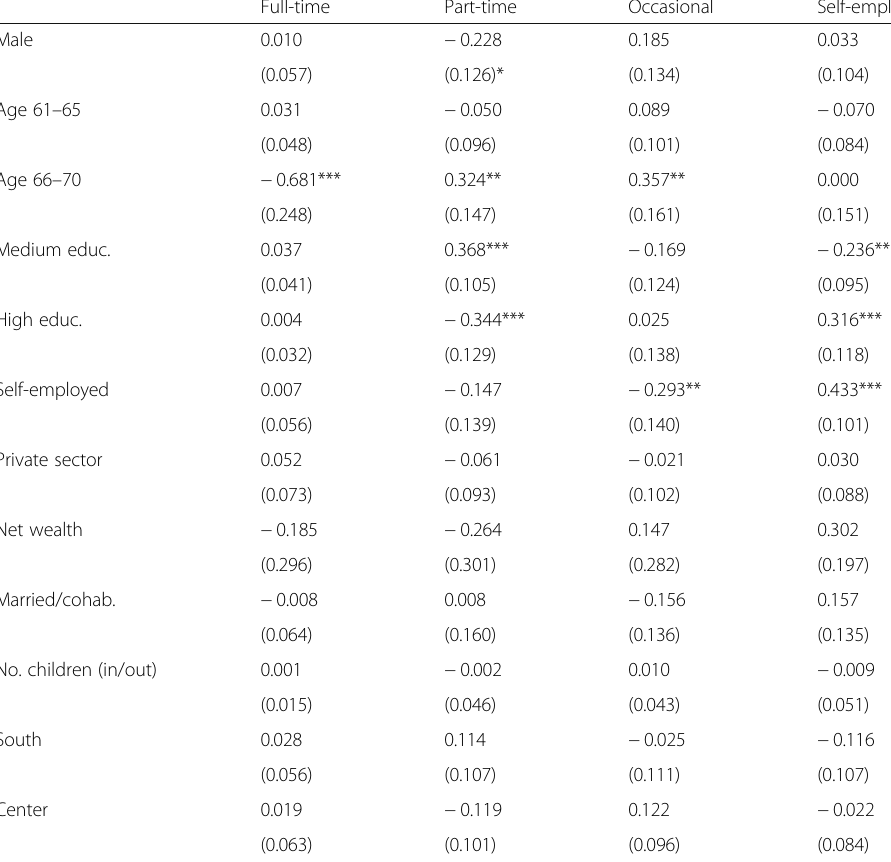
Table 4 Type of job, retirees willing to work. Multinomial logit Full-time Part-time Occasional